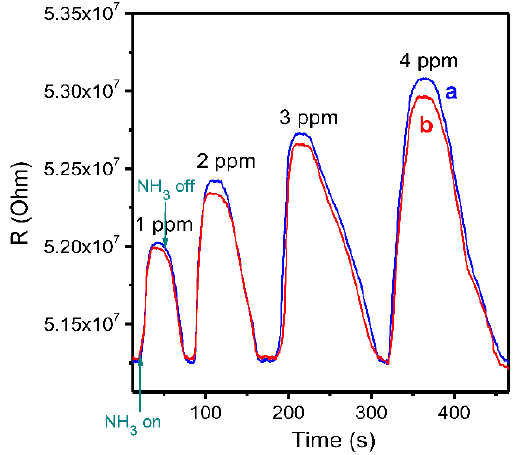
Figure 7. Sensor response of a ZnPcF 4 layer toward ammonia in the concentration range from 1 to 4 ppm, in air ( a ) and in a mixture of gases with the composition close to exhaled air of healthy people (N 2 —76%, O 2 —16%, H 2 O—5%, and CO 2 —3%) ( b